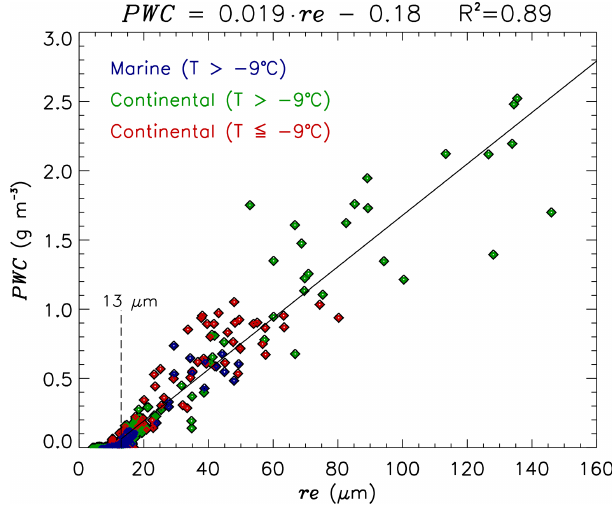
Figure 2. Effective radius of cloud particles ( r e ) vs. precipitation water content (PWC) measured near cloud tops of convective clouds over the Atlantic Ocean for temperatures ( T ) warmer than − 9 ◦ C (in blue), and over the continent for T > − 9 ◦ C (in green) and T ≤ − 9 ◦ C (in red). The black line indicates the fit of PWC as a function of r e (shown on the top of the graphic). The r e threshold of 13µm applied for the fit is based on the value of r e at which light precipitation starts (drizzle water content > 0 . 01gm − 3 ). The coef- ficient of determination ( R 2 ) from the fit function of this analysis is shown on the